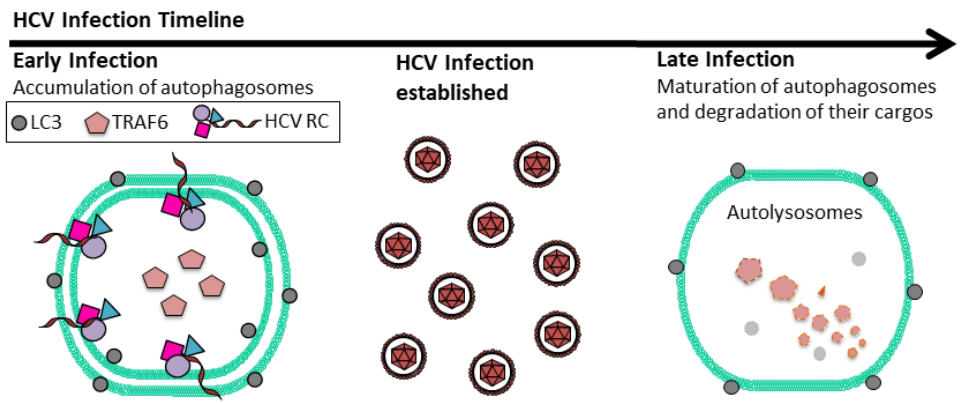
Figure 2. Temporal regulation of autophagic flux by HCV. In the early stage of HCV infection, autophagosomes accumulate in cells due to the delay of their maturation. This increases membrane areas for HCV RNA replication. TRAF6, an important adaptor protein of the host innate immune response, is also sequestered in autophagosomes. As HCV RNA replication climaxes, autophagosomes mature by fusing with lysosomes. At this time point, TRAF6 will undergo autophagic degradation. HCV RC: HCV RNA replication complex; LC3: Lipidated microtubule-associated proteins light chain 3.